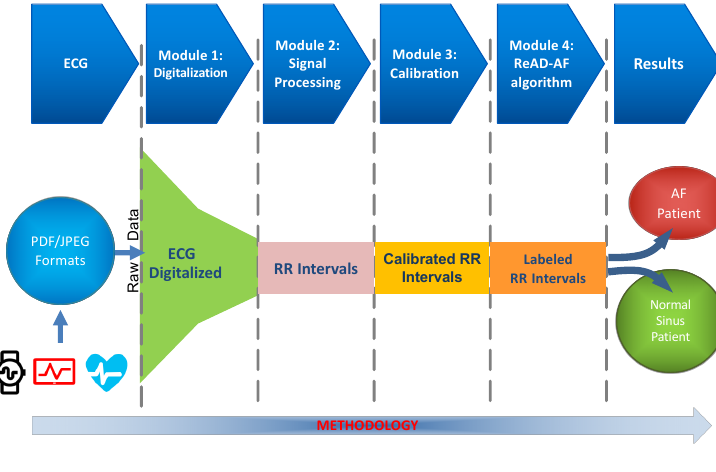
Figure 2. Block diagram showing the main modules that shape the prototype application developed. After the entire procedure, the objective is to determine if a patient is with normal sinus rhythm (NS) or with atrial fibrillation